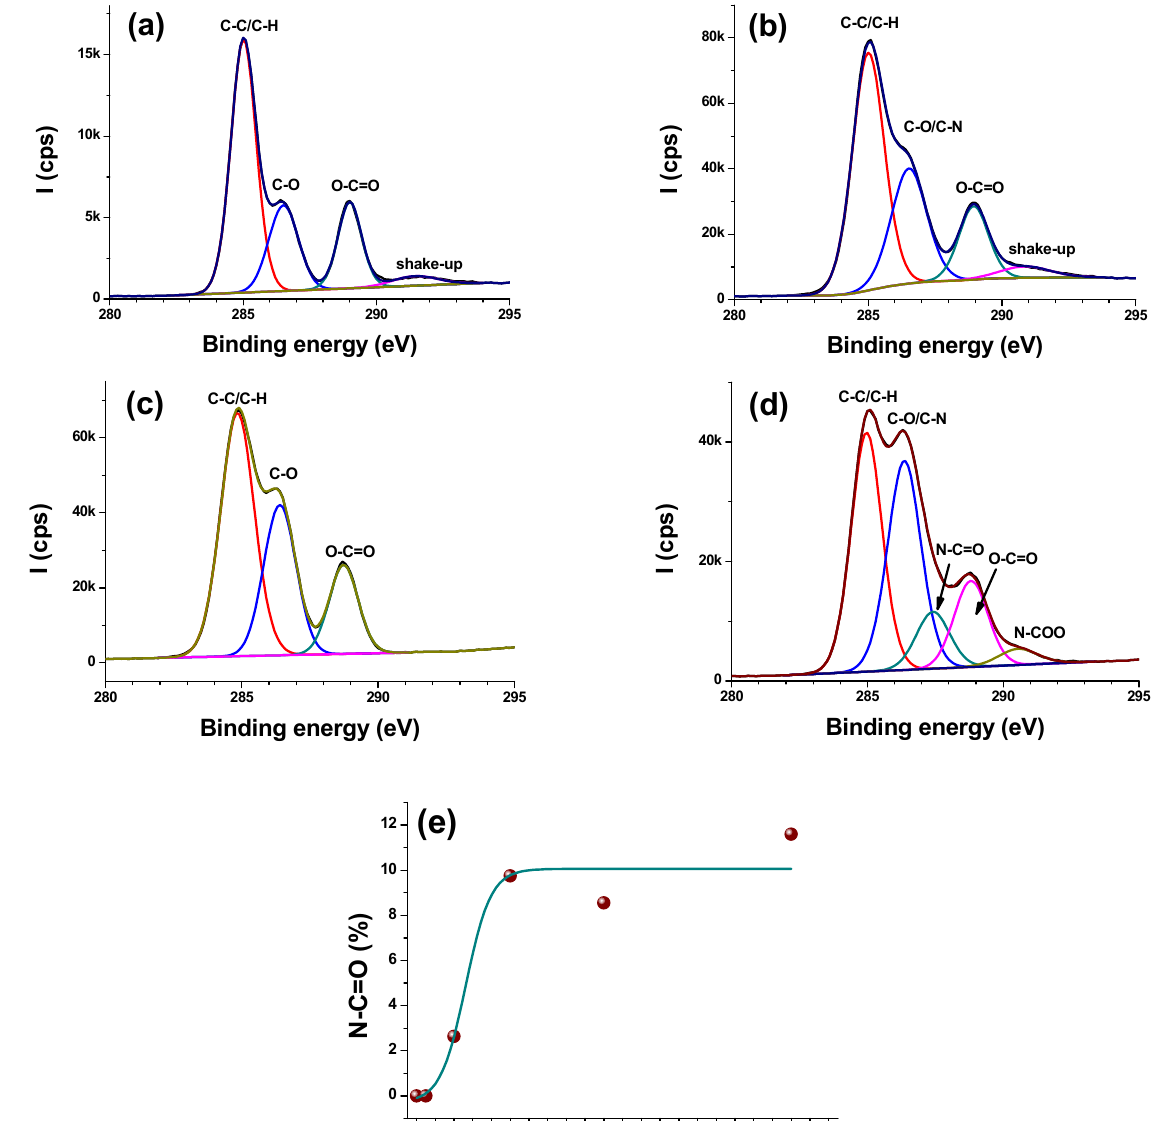
Figure 3. High resolution C1s regions from ( a ) PET, ( b ) PET-DMA. ( c ) PET-DMA-PHEMA, and ( d ) PET-DMA-PHEMA-I-FBN 5 . ( e ) The contribution of N-C=O (amide) groups to the C1s peak is plotted versus fibronectin concentration (in %).